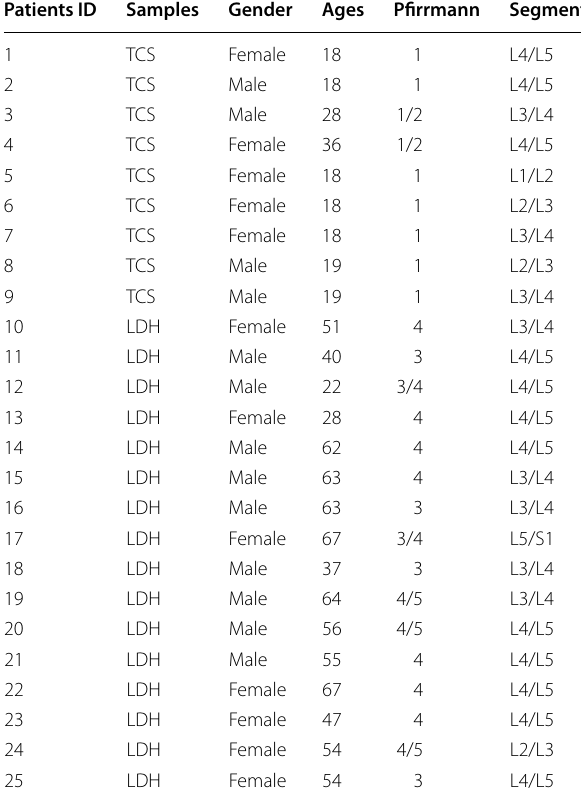
Table 1 Clinicopathological characteristics of LDH patients and control patients with